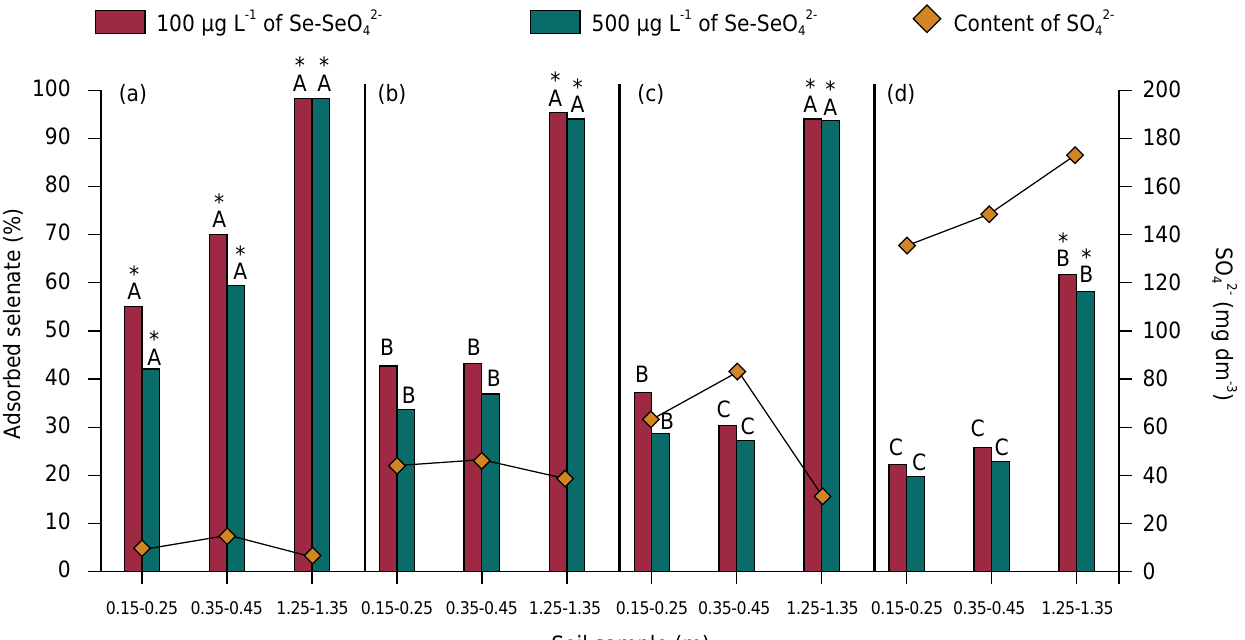
Figure 1. Selenate (SeO 42- ) adsorption ( %) at three soil layers of a Latossolo Vermelho distrófico (Oxisol). The letters (a), (b), (c), and (d) correspond respectively to the rates of phosphogypsum applied to the soil, as follows: 0, 7, 14, and 56 t ha -1 . The letters and the (*) above the bars compare the means by the Scott-Knott test at 95 % probability. The letters compare the adsorption of SeO 4 2- under the influence of different sulfate (SO 4 2- ) contents for the same soil layers. Bars with (*) indicate statistical differences in SeO 42- adsorption rates among soil layers within the same applied phosphogypsum